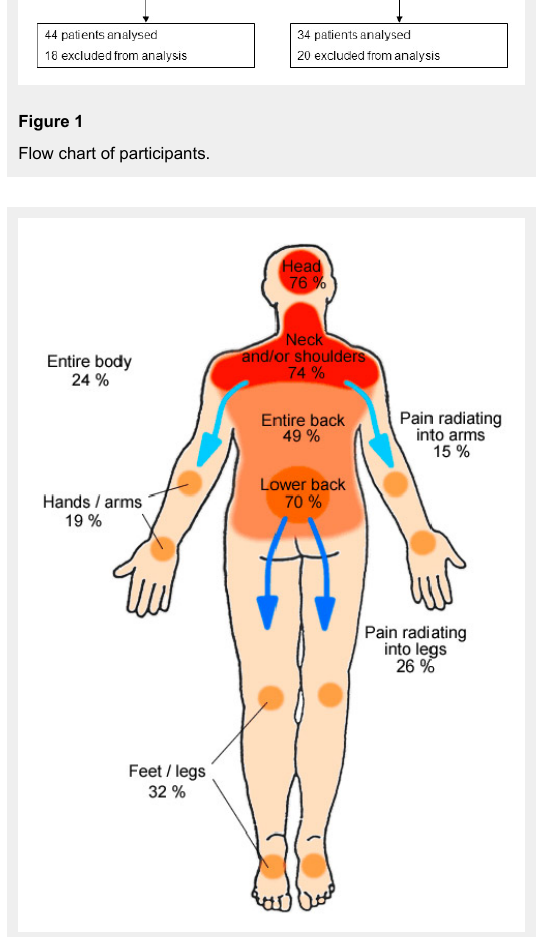
Graphical display of pain localisation, reported by the patients on a sketch as shown. Multiple responses were allowed (n =